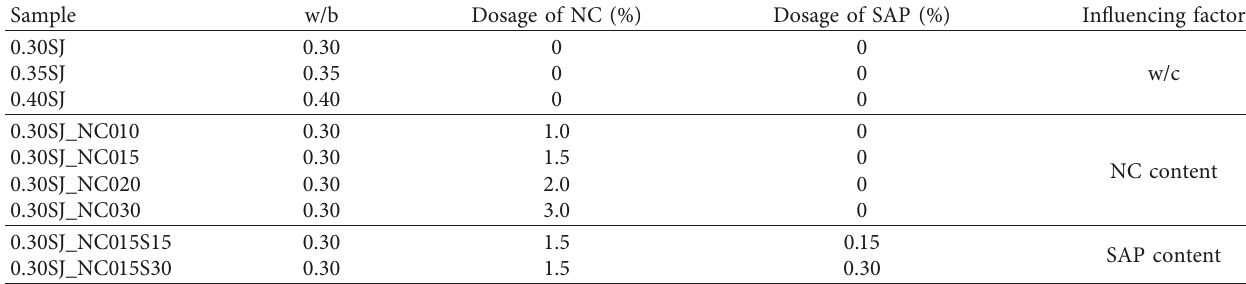
Table 2: Mix proportion of cement pastes.